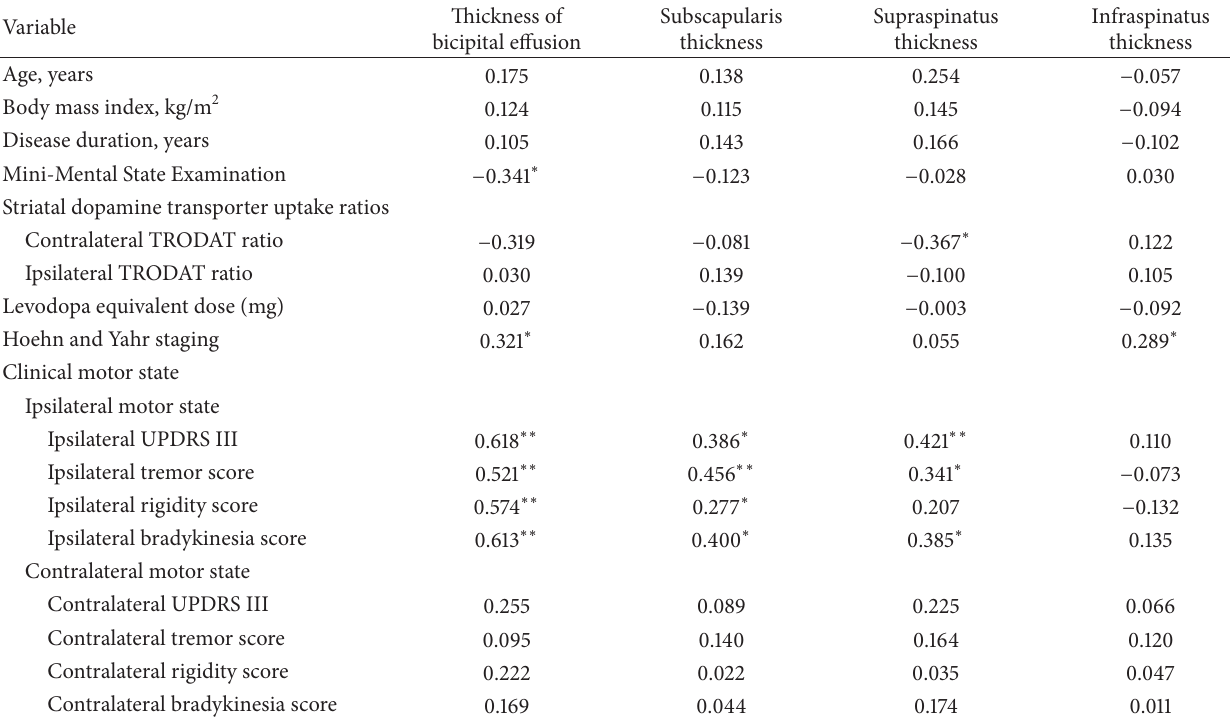
Table 3: Correlation between parameters of shoulder sonography findings and clinical severity in PD